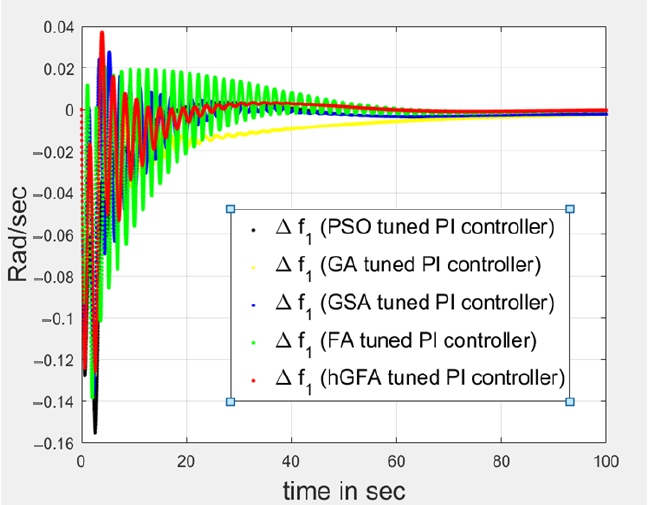
Figure 5. Perturbation in load frequency response in area-1 of HTPS for case study-II.